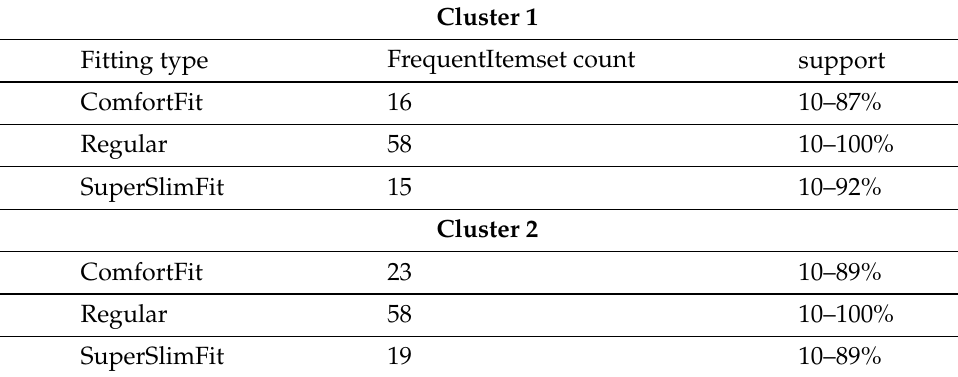
Table 3. Frequent item set statistic for each fitting class.